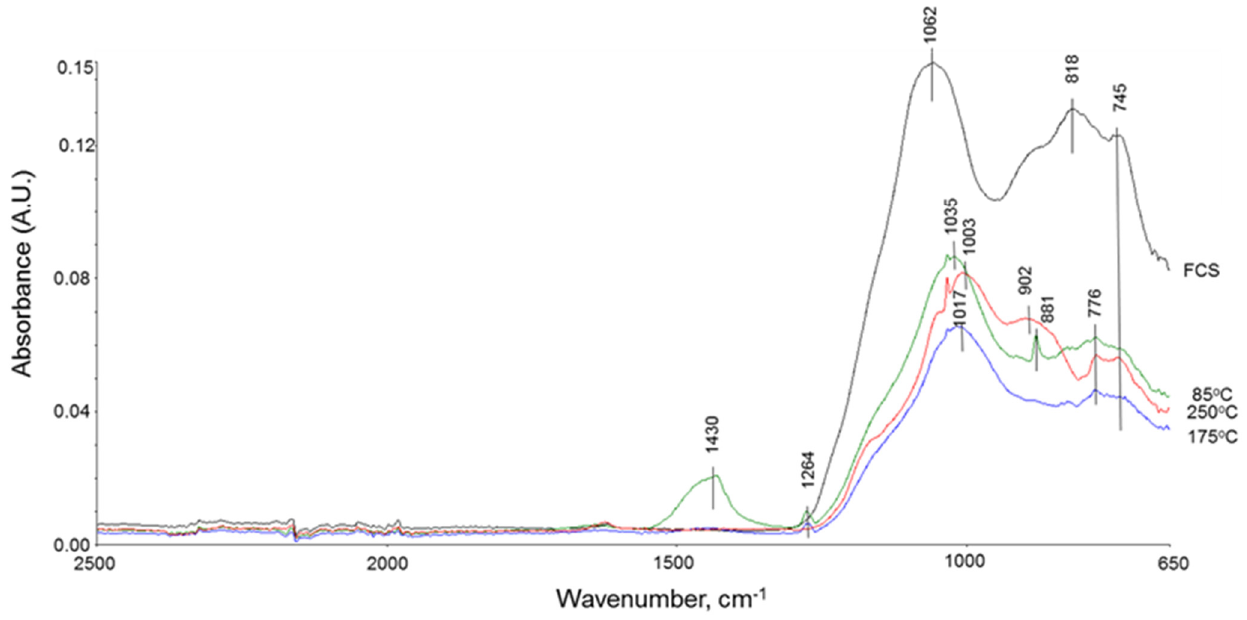
Figure 12. ATR-FTIR spectra for “as-received” FCS, and SMS/PMHS/FCS blends at 85, 175, and 250 ◦ C. Based upon the information described above, Figures 13 and 14 illustrate in situ siloxane depolymerization and conversion to crosslinked silicon-like RIPs at 175 and 250 ◦ C in the PMHS/FCS interfacial boundary region.